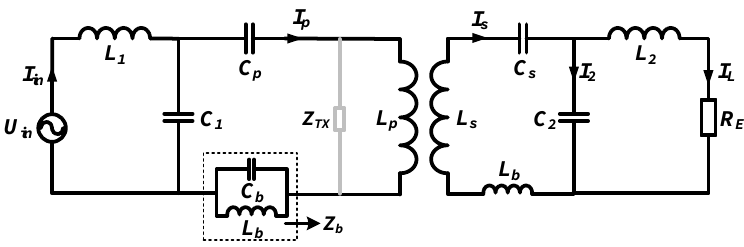
Figure 4. Equivalent circuit of power channel.